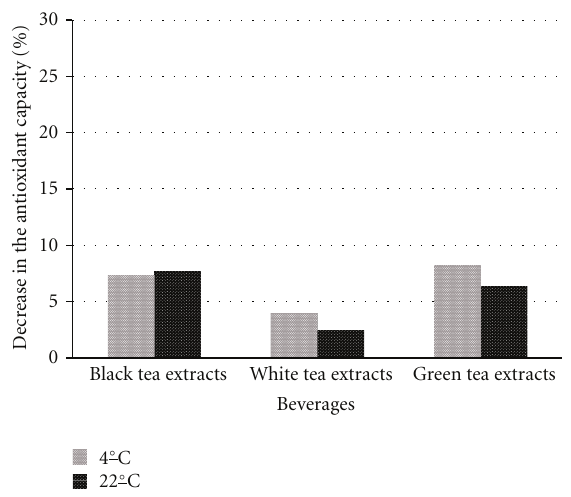
Figure 2: Decrease in the antioxidant capacity in the stored beverages in %, day